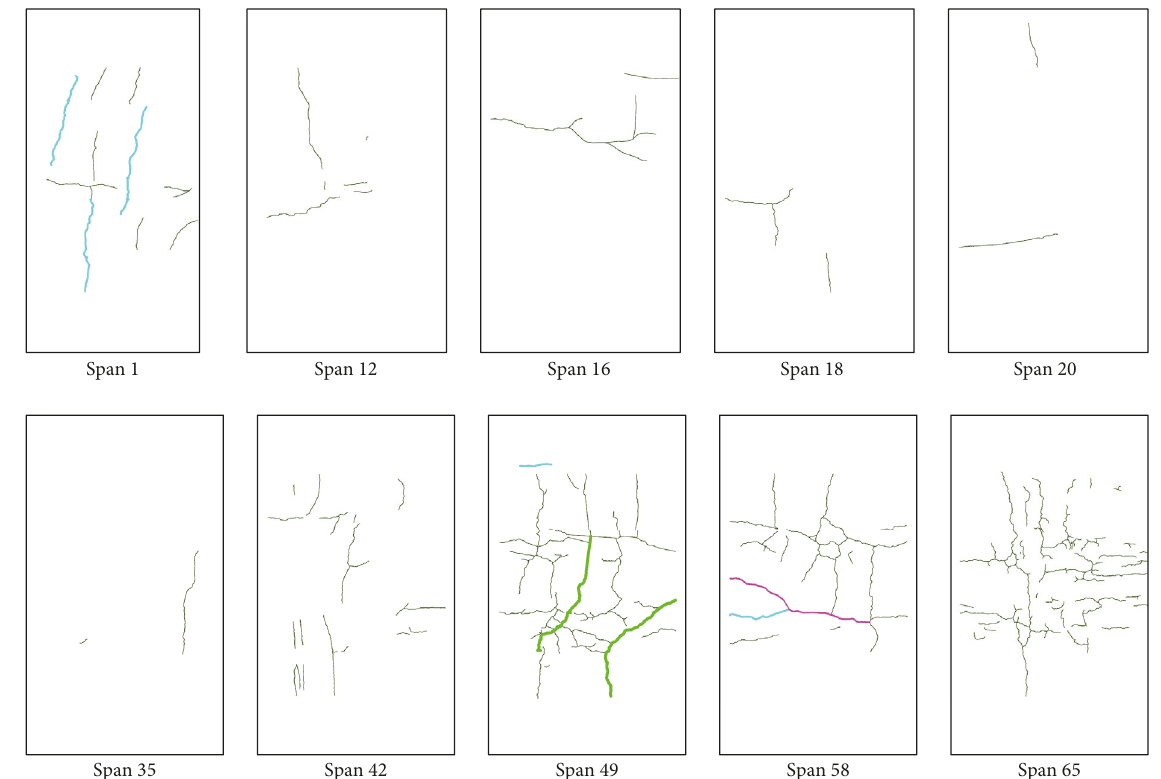
Figure 5: Cracks distribution on tunnel lining surface for ten studied spans.